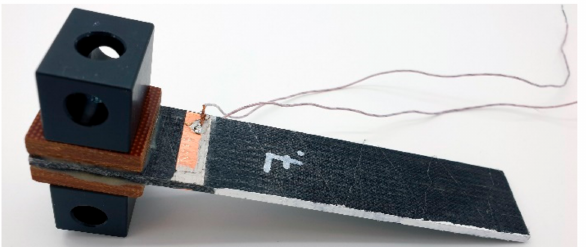
Figure 13. MWCNT-modified GFRP DCB specimen with attached copper electrodes, two glued tabs, and screwed loading blocks.